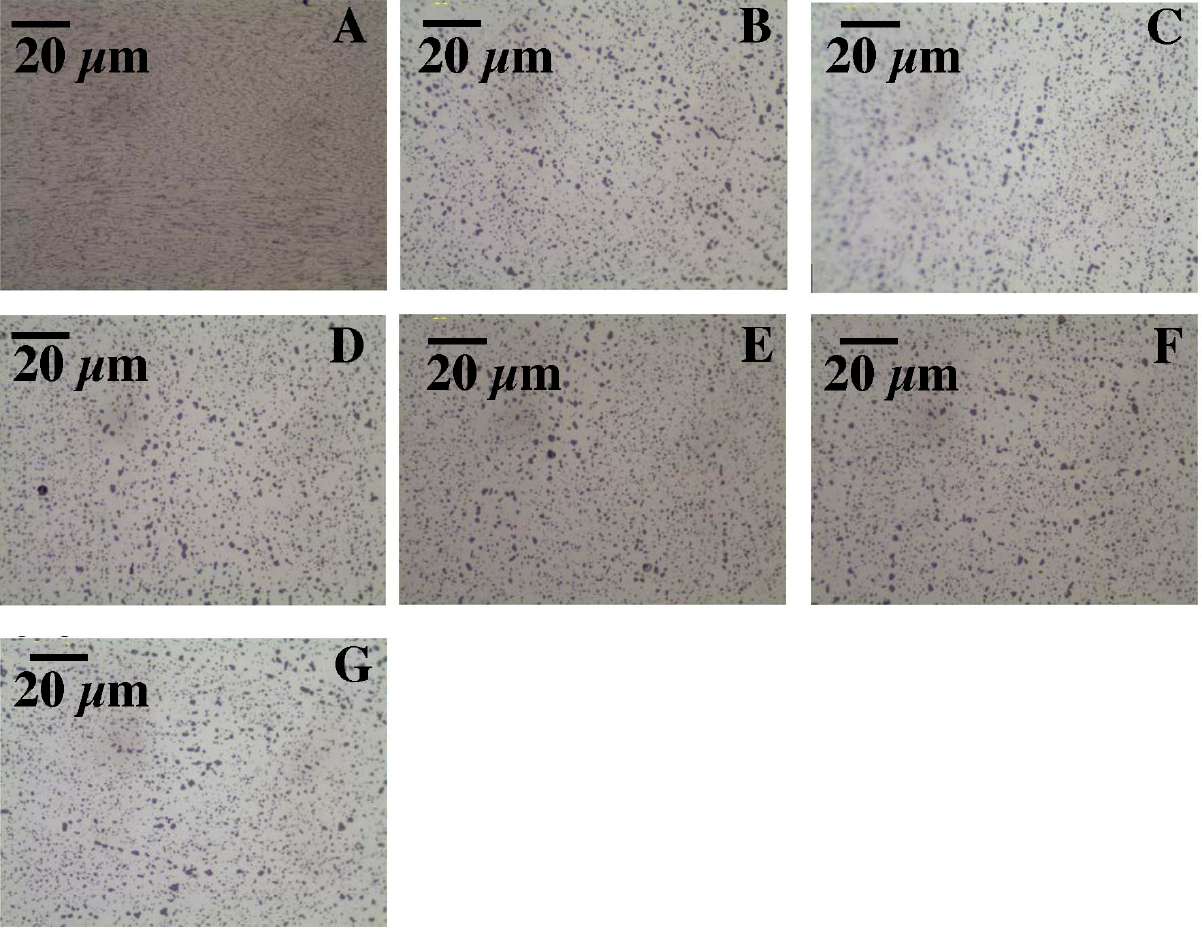
Figure 12. Microstructure of DMLS samples before and after heat treatment (LM): ( A ) after DMLS, ( B ) after supersaturation, ( C ) after supersaturation and ageing—2 h, ( D ) after supersaturation and ageing—4 h, ( E ) after supersaturation and ageing—6 h, ( F ) after supersaturation and ageing—8 h and ( G ) after supersaturation and ageing—16 h; Observation of the cross-section in the middle of thickness for each sample.